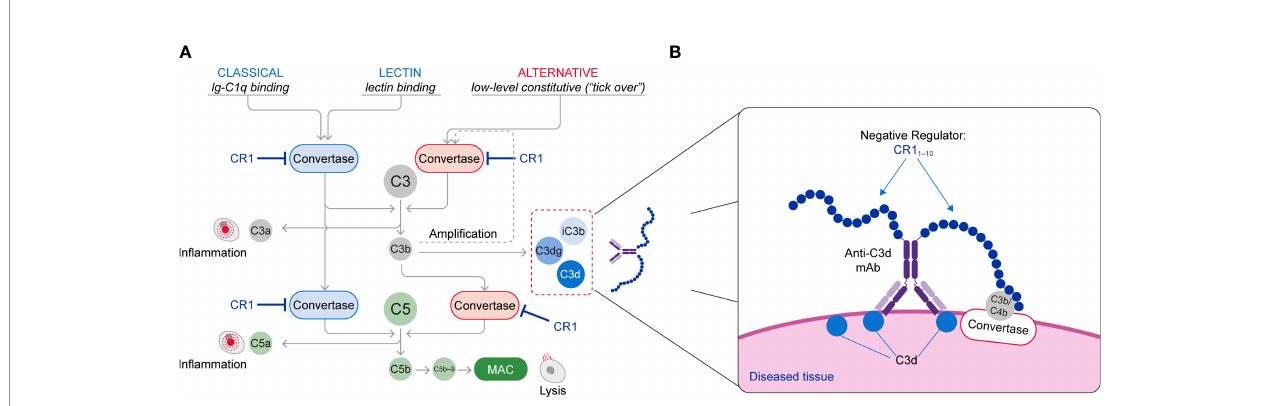
FIGURE 1 | (A) Schematic of the Complement System (Classical, Lectin and Alternative Pathways) and (B) The Mechanism of Action of C3d mAb – CR1 1-10 . The C3d mAb portion of the fusion protein binds to C3d that is deposited on tissue at sites of complement activation and presents the negative regulator protein for binding to the C3/C5 convertases. Binding of the CR1 1-10 negative regulator to the C3/C5 convertases induces their dissociation (decay accelerating activity) and catalytic degradation (co-factor